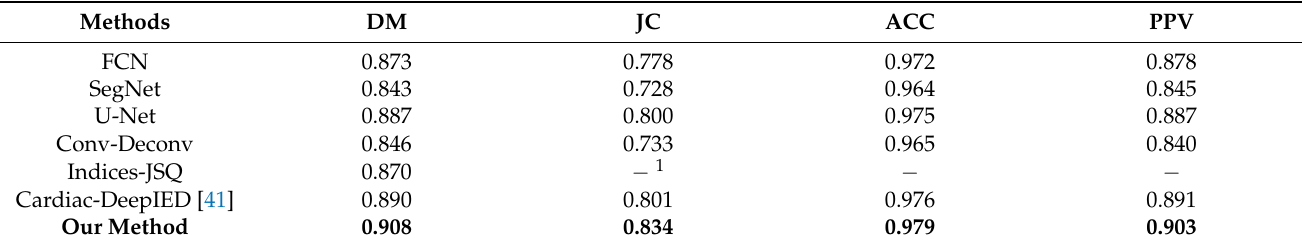
Table 1. The comparison of the suggested method with several popular segmentation methods.